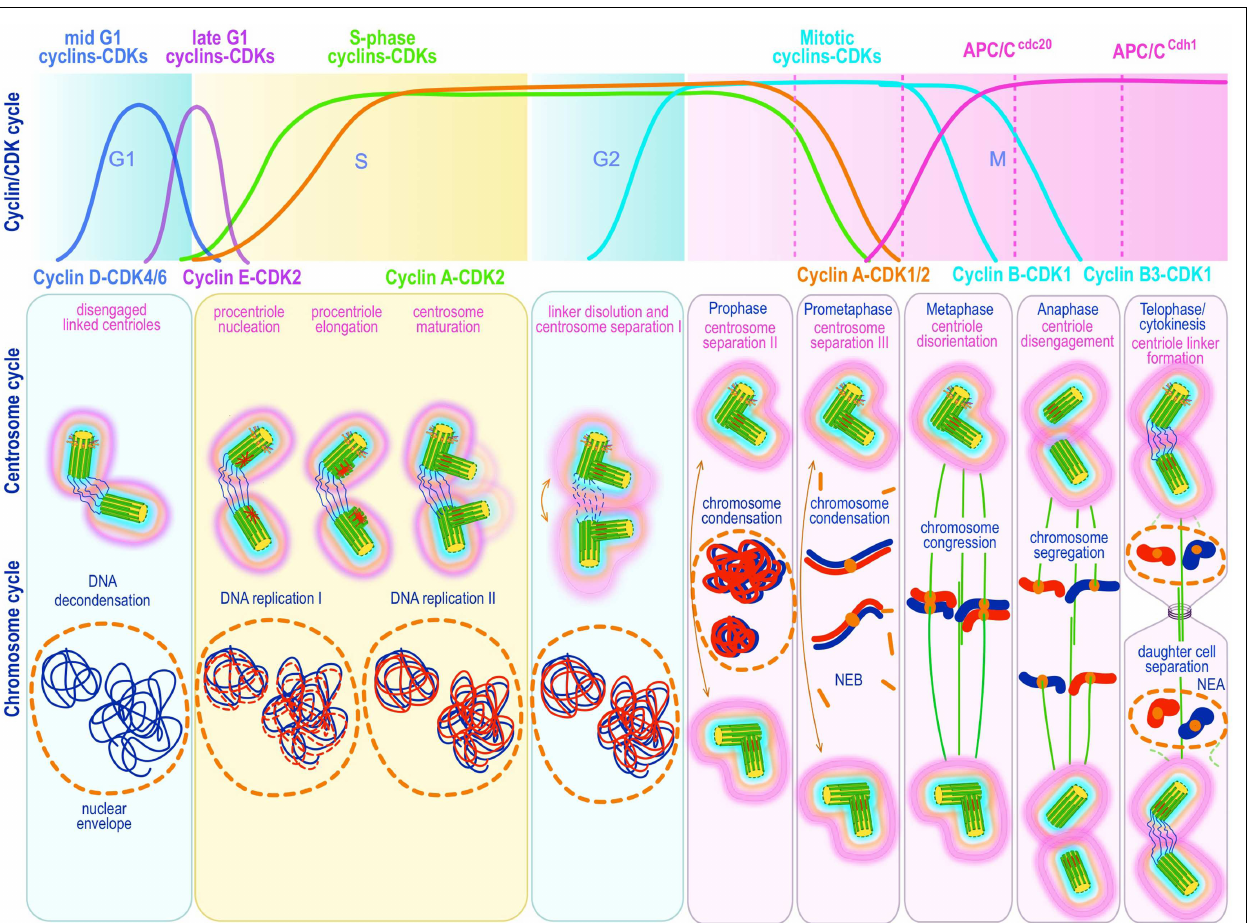
while centrosomes begin to separate and mature further (acquire a full complement of PCM proteins). During prophase centrosomes continue to migrate apart until they reach opposite sides of the condensing chromosomes at metaphase and organize a bipolar spindle in preparation for chromosome segregation.The nuclear (DNA/chromosome) and CDK cycles are shown for correlation and